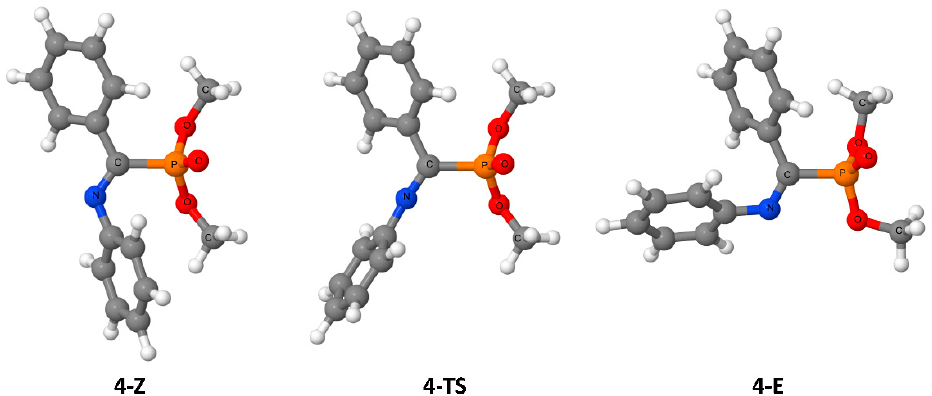
Figure 8. Optimized structures of Z- and E-isomers ( 4-Z and 4-E , respectively) and the transition state of the isomerization reaction 4-Z → 4- Е ( 4-TS ).